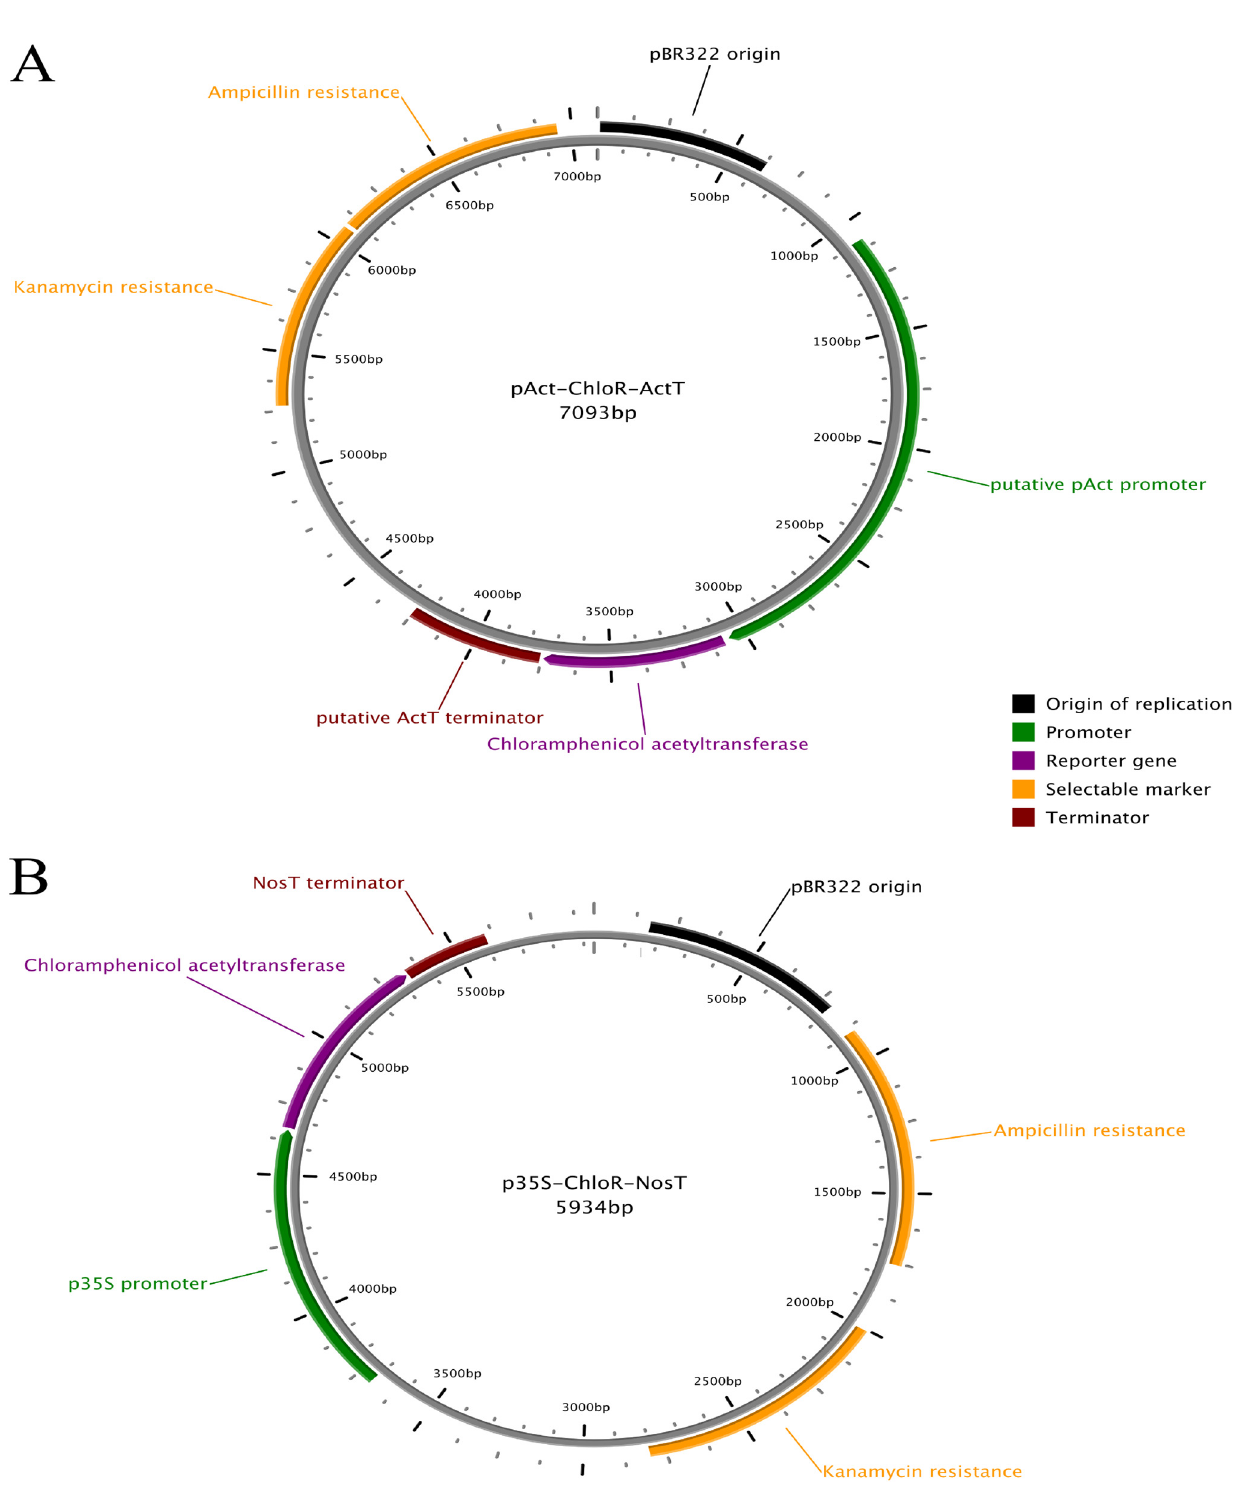
Fig 5. Vector maps for selected transformation plasmids. A) Vector map for plasmid pAct-ChloR-ActT, constructed using the pCR2.1 vector backbone. B) Vector map for plasmid p35S-ChloR-NosT, constructed using the pCR4 vector backbone.